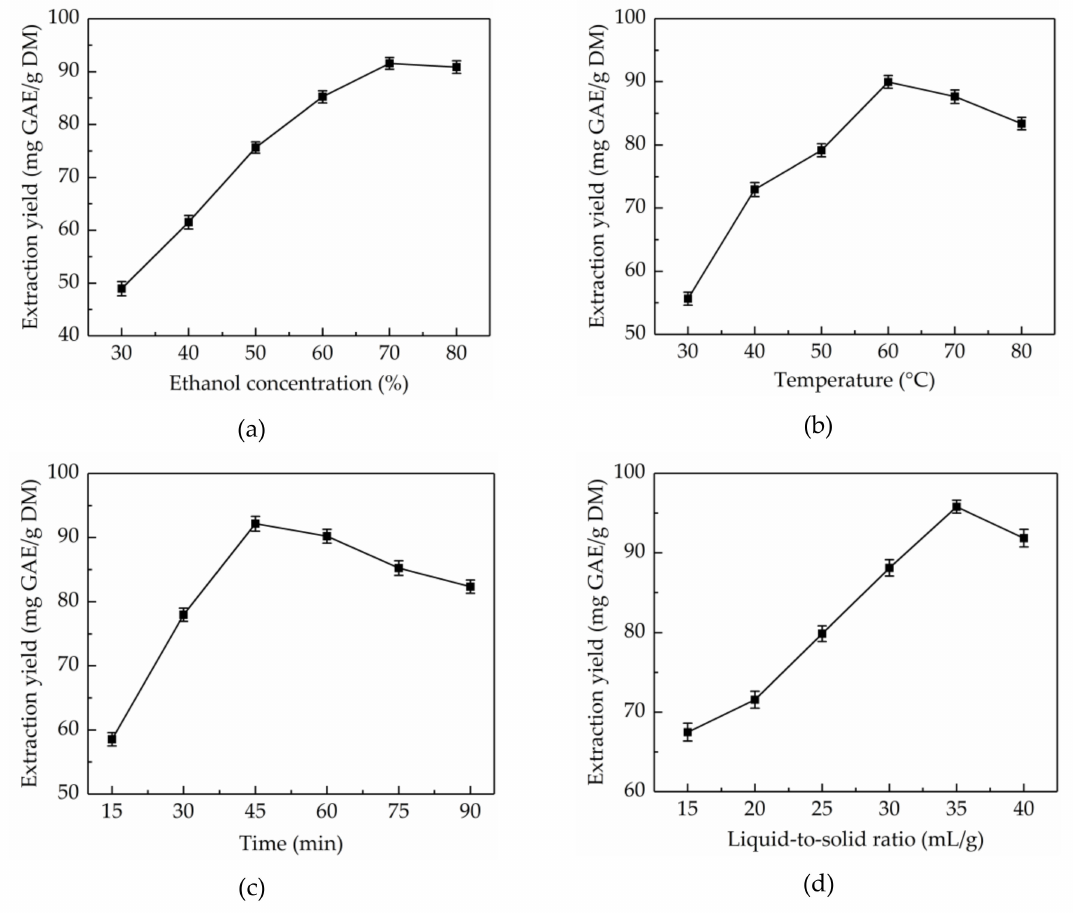
Figure 1. E ff ects of ethanol concentration ( a ), extraction temperature ( b ), extraction time ( c ), and liquid-to-solid ratio ( d ) on the extraction yield of total